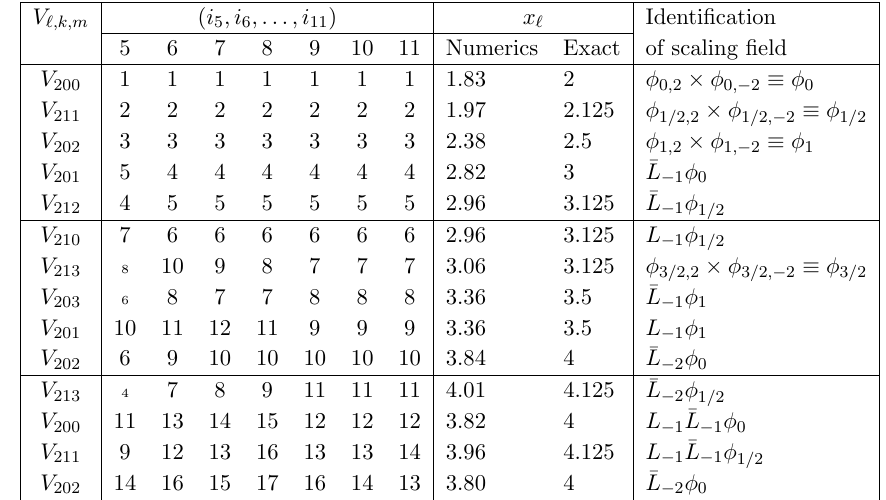
Table 6 . Conformal spectrum in the sector V 2 , for Q =